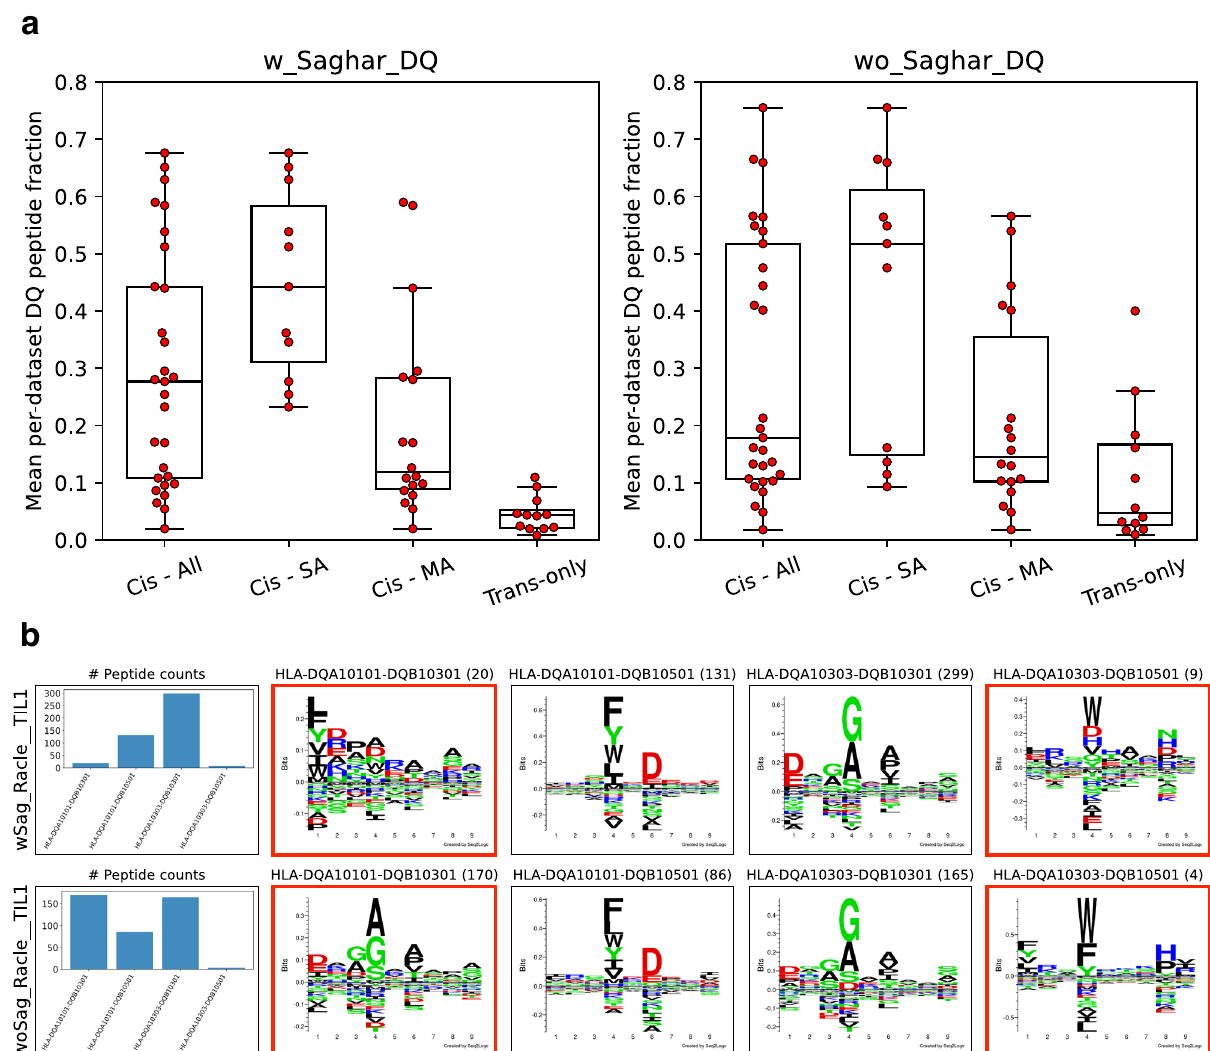
Fig. 4 Contribution of cis and trans-only DQ variants in DQ-heterozygous datasets. a Peptide-count contribution of cis and trans-only molecules in the methods with (w_Saghar_DQ) and without (wo_Saghar_DQ) the novel data. Each point shows the mean per-dataset peptide fraction for a given DQ molecule. For each method, trans-only molecules are shown in one boxplot ( n = 12), while cis molecules are shown in three categories, namely all cis molecules (Cis – All, n = 29), cis molecules found in the DQ-SA training data (Cis – SA, n = 11), and cis molecules only found in the DQ-MA training data (Cis – MA, n = 18). Each boxplot shows the median inside the IQR between the upper and lower quartiles, with whiskers extending to at most 1.5 times the IQR. b DQ motif deconvolution for the Racle__TIL1 dataset. The rows correspond to the methods trained with (wSag) and without (woSag) the novel data, respectively. Peptide counts (excluding trash peptides) are displayed in parenthesis in the logo plot titles. Trans-only molecules are highlighted in red